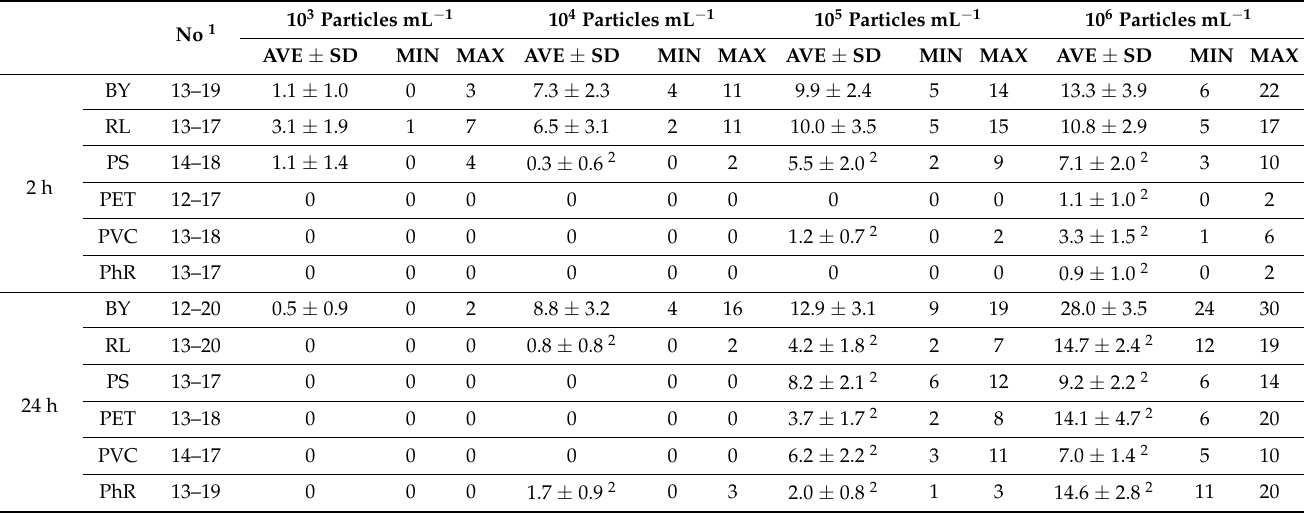
Table 1. Number of vacuoles formed by the protozoan S. ambiguum in suspensions with different microparticle concentra- tions after 2 h and 24 h of